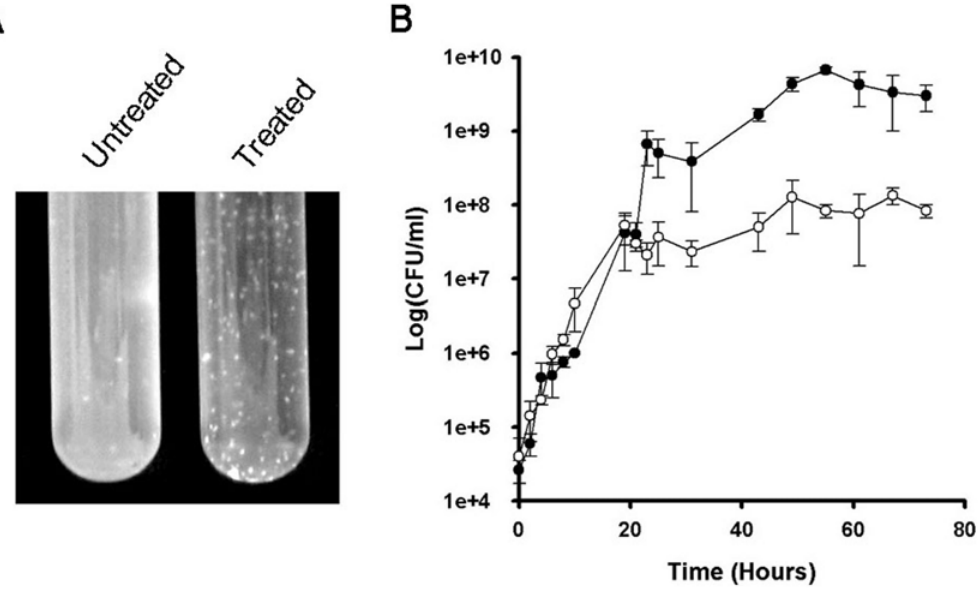
Figure 3. Invivo effect of platensimycin against M.smegmatis . (A) Clarification of cultures due to clumping and cellular lysis at time point 72 h. (B) Cultures were grown to an OD 600 nm of 0.4 upon which 14 m g/ml of platensimycin was added, samples were take over a 72 h period. Viable counts were calculated as per the methods where the mean CFU per millilitre from three independent experiments was calculated. $ , M. smegmatis ; # , M. smegmatis + platensimycin.